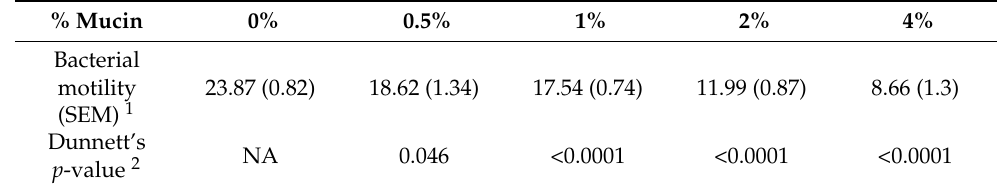
Table 1. Motile distance (mm) of E. coli in mucin from central inoculation point. % Mucin